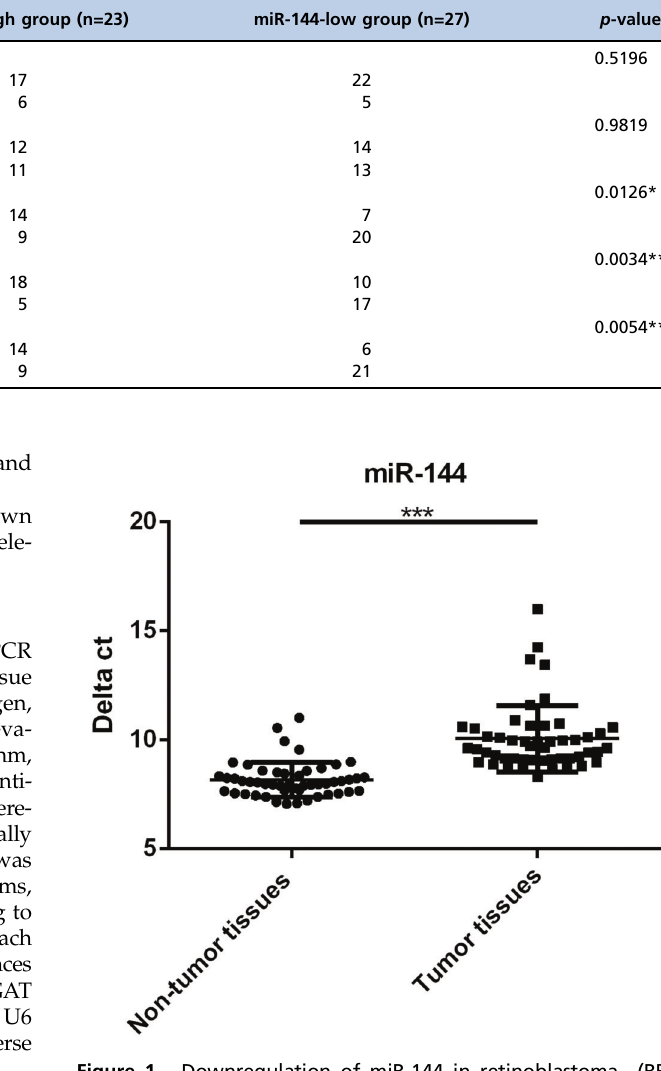
Figure 1 - Downregulation of miR-144 in retinoblastoma (RB) tumor tissues, in comparison with non-tumor tissues. *** p o 0.001.